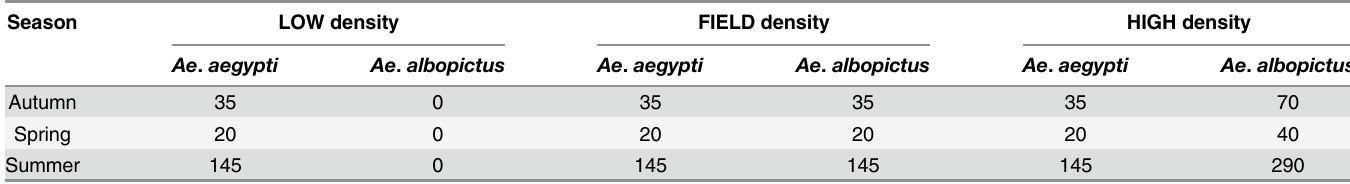
Table 2. Number of 1 st instar larvae of Ae . aegypti and Ae . albopictus used in each density treatment in the three experiments.